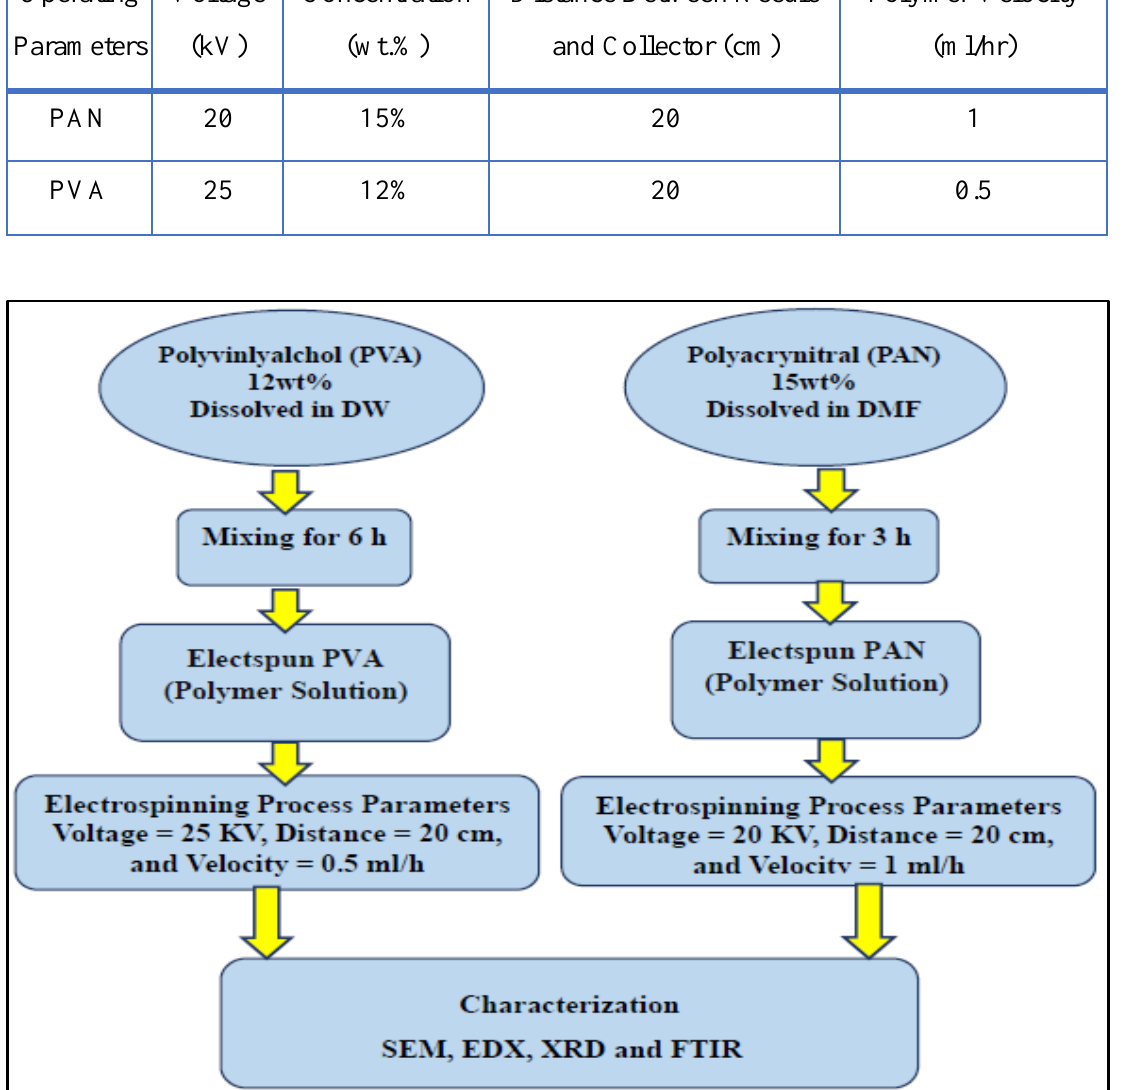
Figure 3: The sequences of preparation stages of PAN and PVA nanofilters via electrospinning